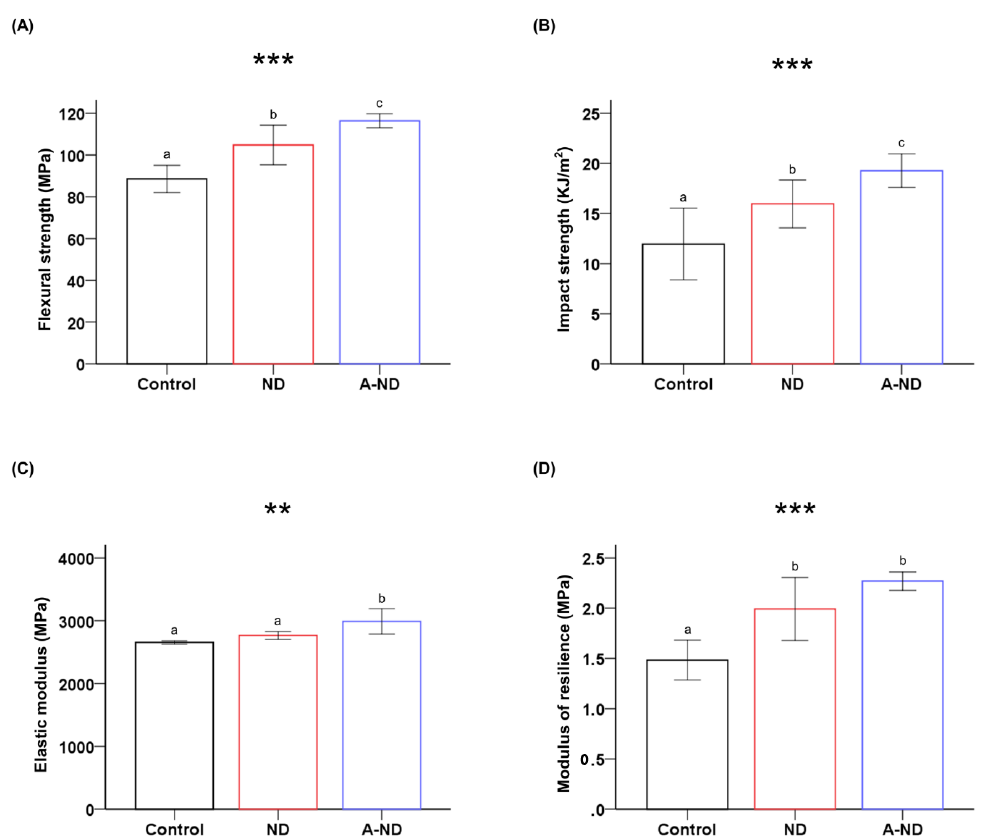
Figure 6. Comparing the ( A ) flexural strengths; ( B ) impact strengths; ( C ) elastic moduli; and ( D ) moduli of resilience of the various groups of samples. Di ff erent lowercase letters indicate significant di ff erences. ** p < 0.01, *** p <